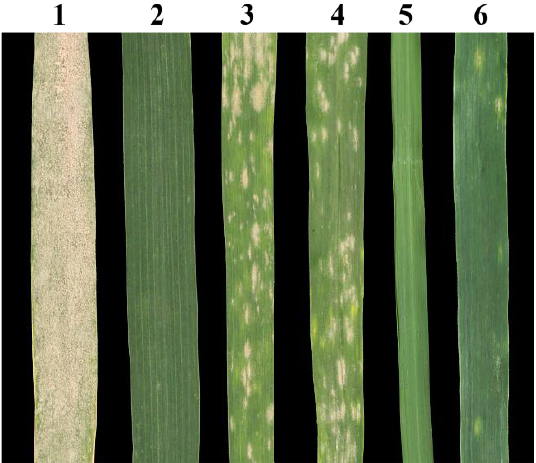
Figure 4. Powdery mildew responses of the wheat – P. huashanica disomic addition line 18-1-5, its wheat parents, and the controls at the adult plant stage. ( 1 ) MY11; ( 2 ) L658; ( 3 ) CS; ( 4 ) CS ph2b ; ( 5 ) P. huashanica ; and ( 6 ) 18-1-5 (wheat – P. huashanica 7Ns disomic addition line).